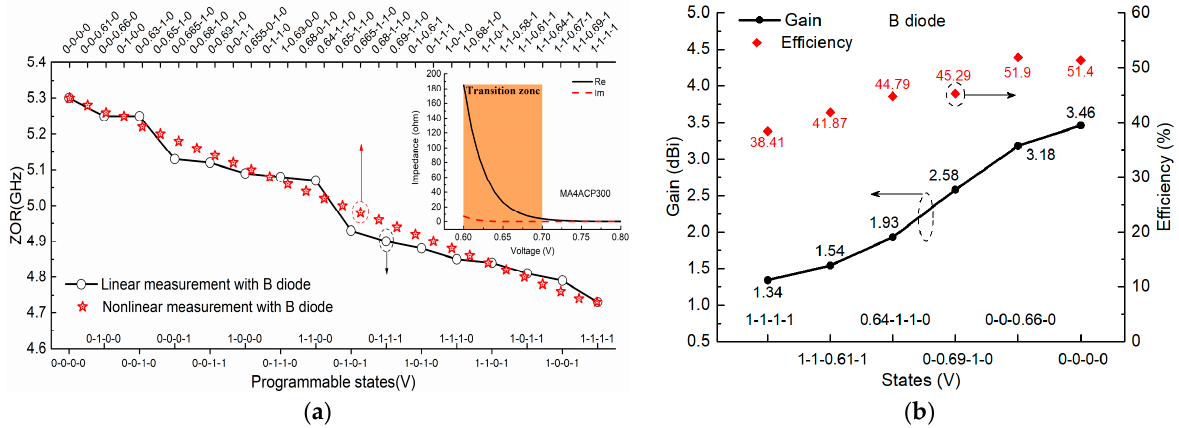
Figure 11. ( a ) Similar nonlinear advantages over linear case in achieving uniform tuning with diode B working in the transition zone; ( b ) measured gains and radiation efficiency of the two extreme states and four nonlinear states.